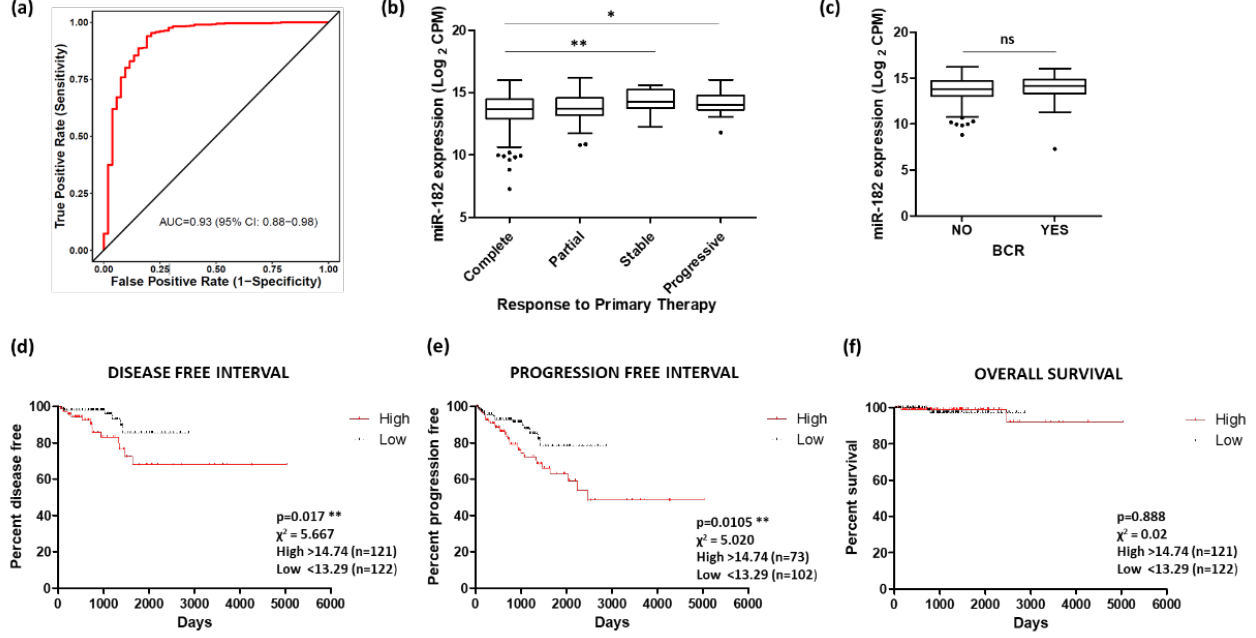
Figure 7. Potential of miR-182 as a biomarker of prostate cancer. ( a ) ROC curve analysis demonstrating that miR-182 shows high potential for distinguishing between tumor and normal tissue. Analysis performed using CancerMIRNome based on TCGA PRAD patient cohort. ( b ) Significant difference in miR-182 levels between patient remission response after primary therapy ( n , complete = 380, partial = 41, stable = 27, progressive = 31). (One-way ANOVA with multiple comparison tests, * p < 0.05, ** p < 0.01). ( c ) Biochemical recurrence (BCR) showed no significant difference with levels of miR-182 ( n , no recurrence = 407, recurrence = 61). (Welch’s t -test, p = ns). For KM plots, patients were divided into quartiles based on miR-182 expression. Quartile with highest miR-182 expression showed significantly reduced time for ( d ) Disease-free interval and ( e ) Progression-free interval, compared to quartile with lowest miR-182 expression. ( f ) No significant difference was found between these quartiles for Overall survival. (All log-rank (Mantel–Cox) test, ** p < 0.01). Data analysis for ( b )–( f ) was performed using UCSC Xena based on TCGA PRAD patient cohort. n = number; ns = non-significant.